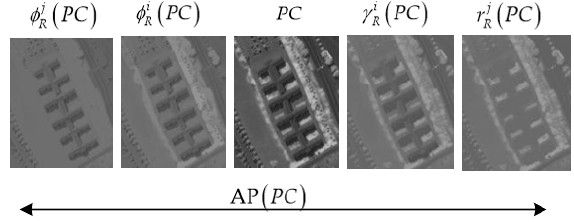
Figure 2. Using attribute filtering to build AP samples for a single